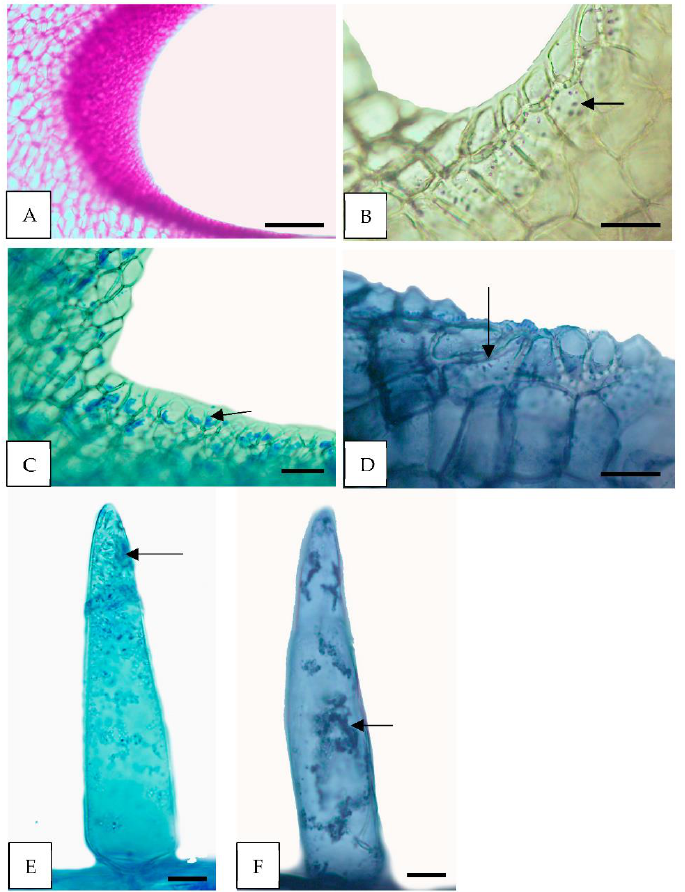
Figure 4. Histochemical tests of the floral glands of H. cagayanensis ; ( A – D ) Secondary nectaries ( sn ); ( E , F ) Conical trihomes ( ct ). ( A ) Polysaccharides stained pink in nectariferous tissue of sn (PAS); ( B ) tiny starch grains (arrows, IKI); ( C , E ) protein stains with CB; ( D , F ) few lipid droplets (arrows, SBB). PAS, periodic acid-Schiff reaction; IKI, Lugol’s reagent; CB, Commassie Blue; SBB, Sudan Black B. Scale: ( A ) =200 µ m, ( C ) =100 µ m; ( B , D – F ) =50 µ m.